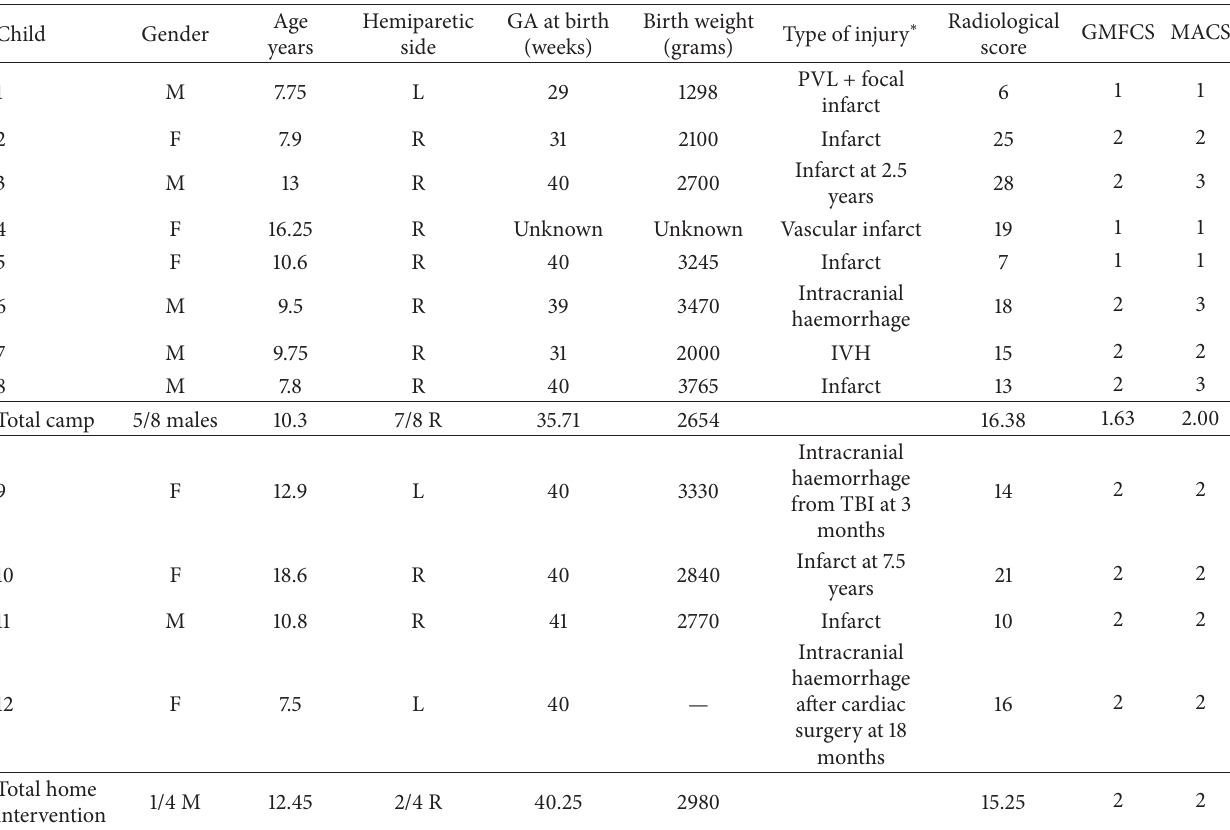
Table 1: Participant characteristics.